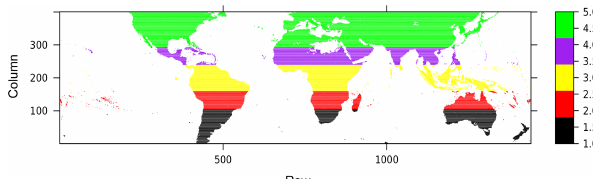
Figure 1. Latitudinal zones used in this study. Black: southern tem- perate 23.5 to 50.0 ◦ S, red: southern tropical 10.0 to 23.5 ◦ S, yel- low: equatorial tropical 10.0 ◦ N to 10.0 ◦ S, purple: northern tropical 23.5 to 10.0 ◦ N and green: northern temperate 50.0 ◦ N to 23.5 ◦ S. Analyses are restricted to the area 50.0 ◦ N to 50.0 ◦ S because of the bounds of data validity in the TRMM and TRMM-RT precipitation data products (Table